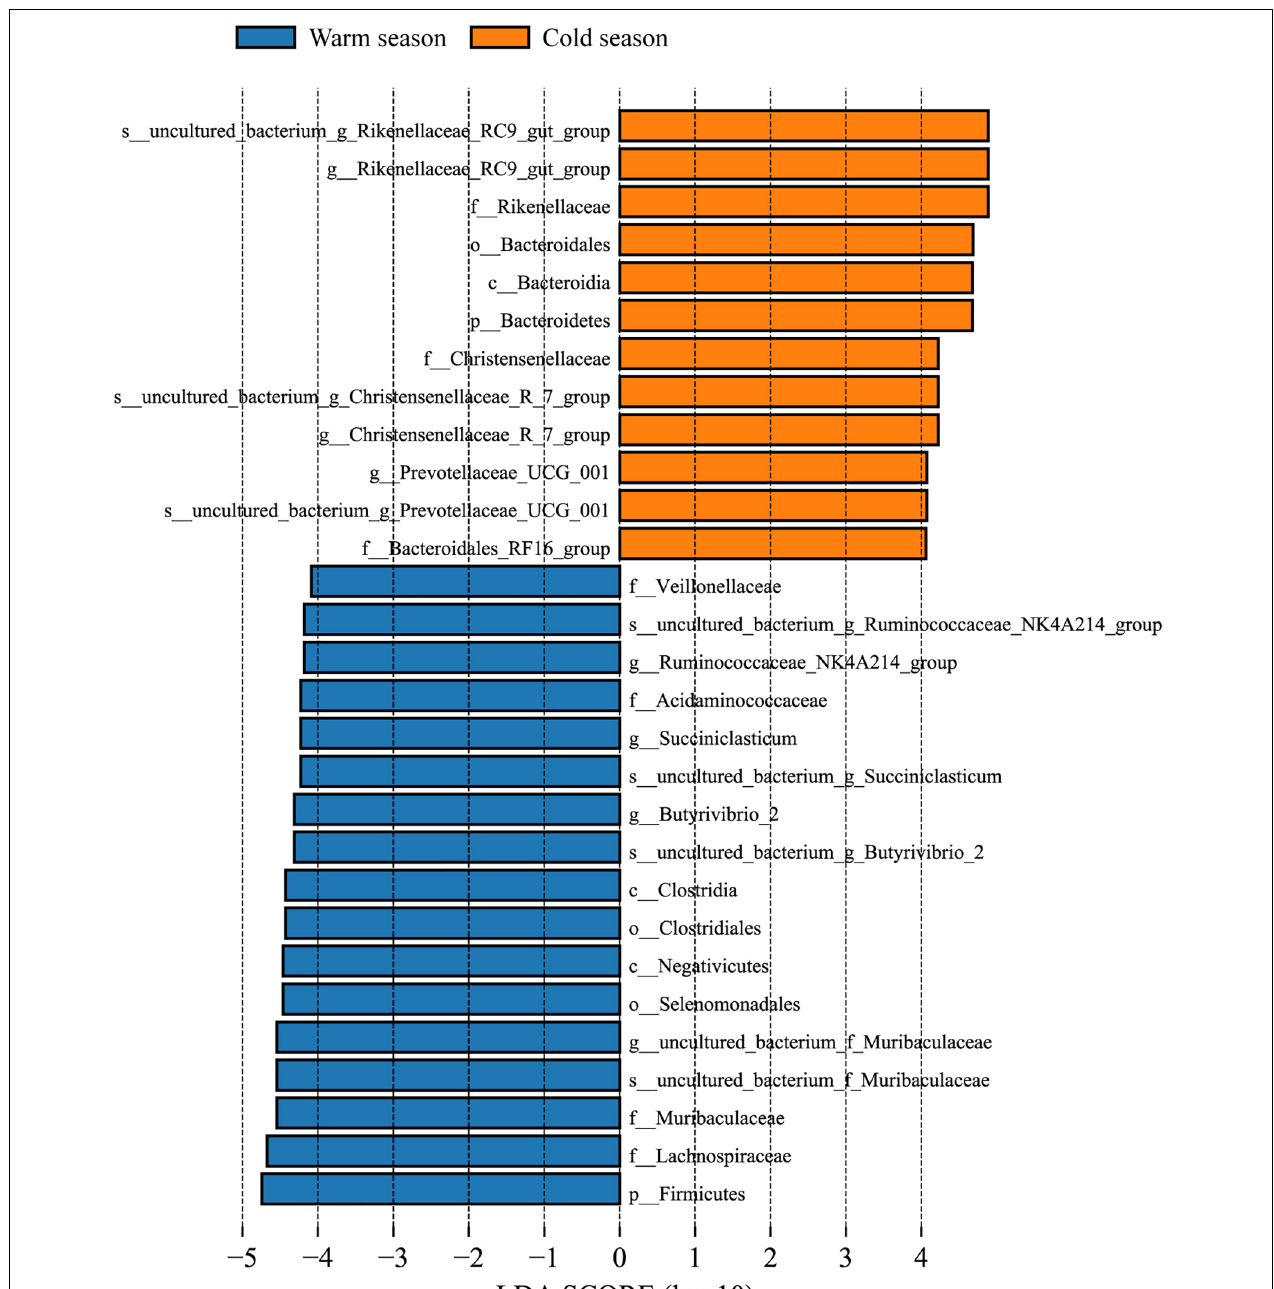
FIGURE 3 | LDA value distribution histogram. LDA value > 4, and the length of the bar chart represents the influence of different species.